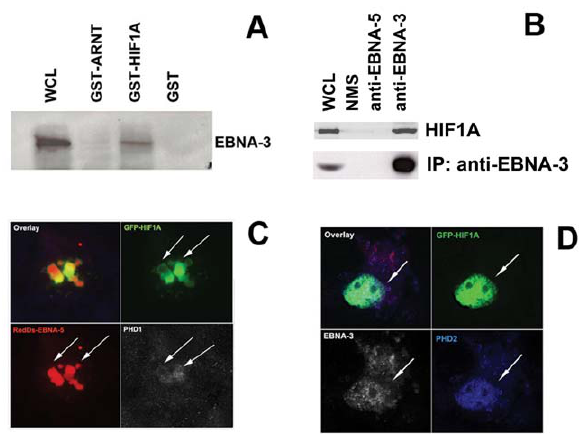
Figure 2. HIF1A binds to EBNA-3, and PHDs 1 and 2 colocalize with EBNA-5 and EBNA-3, respectively. A – GST pulldown assay and Western blotting from lymphoblastoid cell lysates. EBNA-3 was detected in a complex with HIF1A protein. As a positive control, 5% of